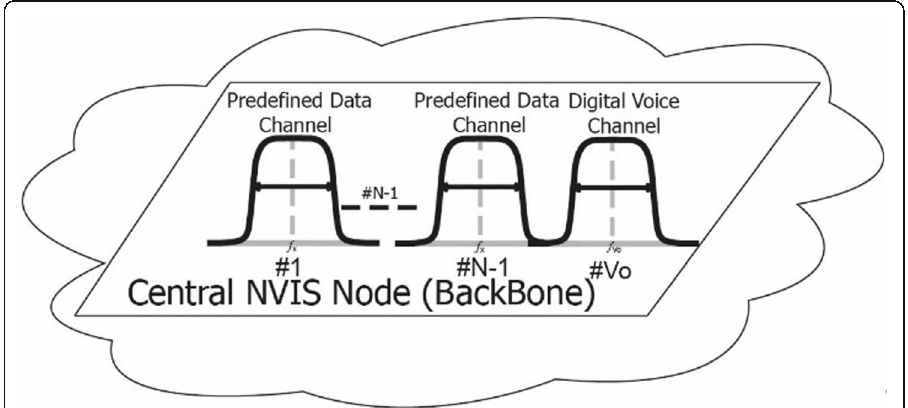
Fig. 14 Central NVIS node. Frequency and bandwidth distribution of each NVJS channel of the